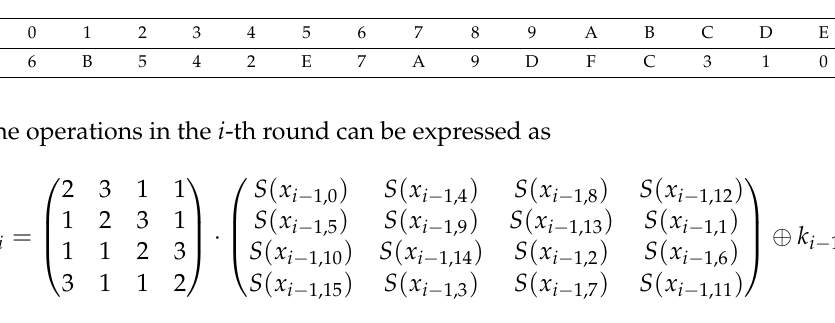
Table 2. The Sbox for the small-scale